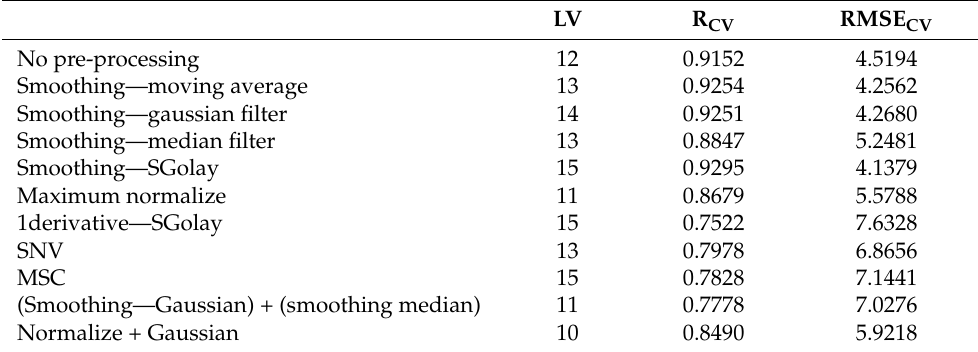
Table 5. Results of partial least squares (PLS) models obtained with different pre-processing methods for predicting the profenofos pesticide residual.